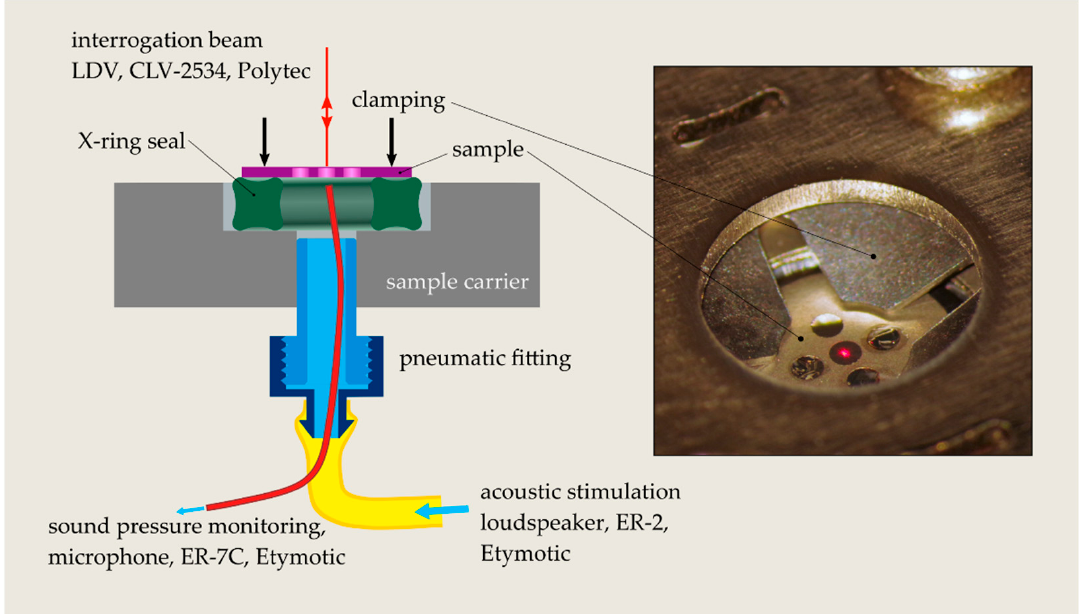
Figure 6. Schematic drawing of the setup for stiffness measurement on the fabricated diaphragms. The method relies on the measurement of the diaphragm response to acoustic stimulation using a single-point LDV system. The microscope image shows a sample with diaphragms clamped down on a rubber seal ring. The interrogation laser beam is positioned in the center of the diaphragm. Three of the five diaphragms are broken and thus sealed with epoxy adhesive.